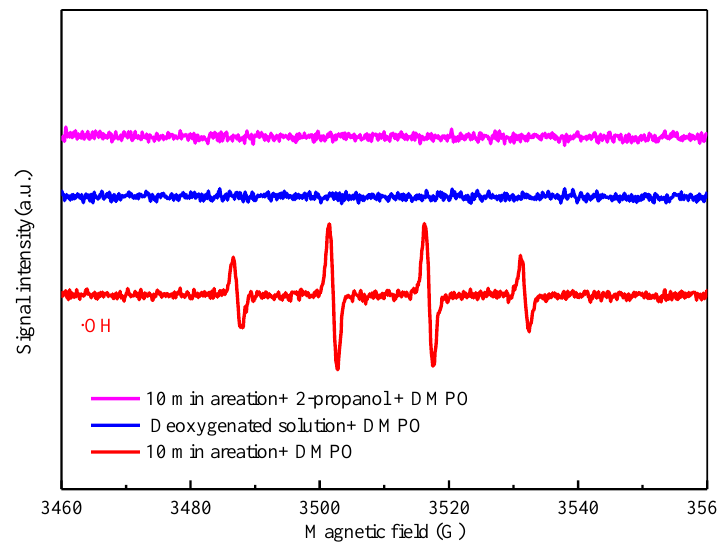
Figure 7. ESR spectra for •OH produced in different systems.